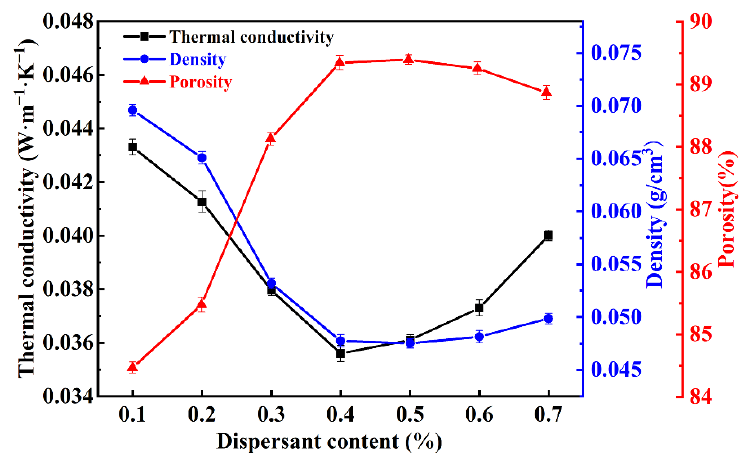
Figure 6. Density, porosity, and thermal conductivity of SiO 2 fibrous porous materials with different SHMP contents.